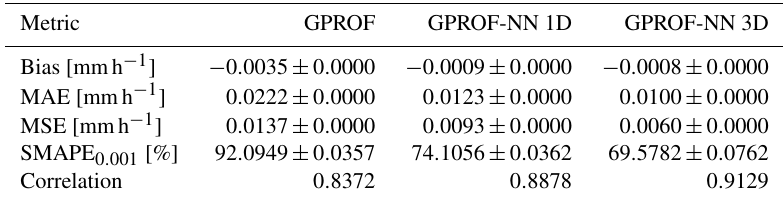
Table C7. The same as Table 5 but for IWP.